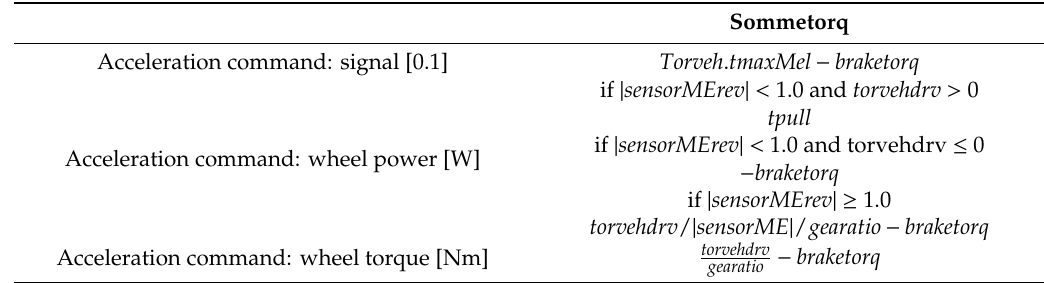
Table 9. Torque required by the driver.